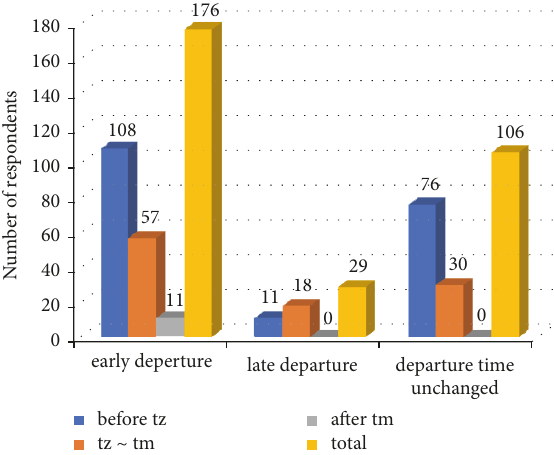
Figure 7: The impact of insufficient parking spaces on expected arrival